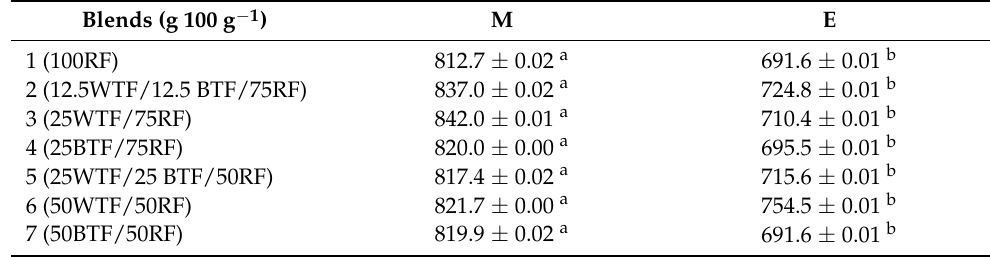
Table 6. Bulk density of